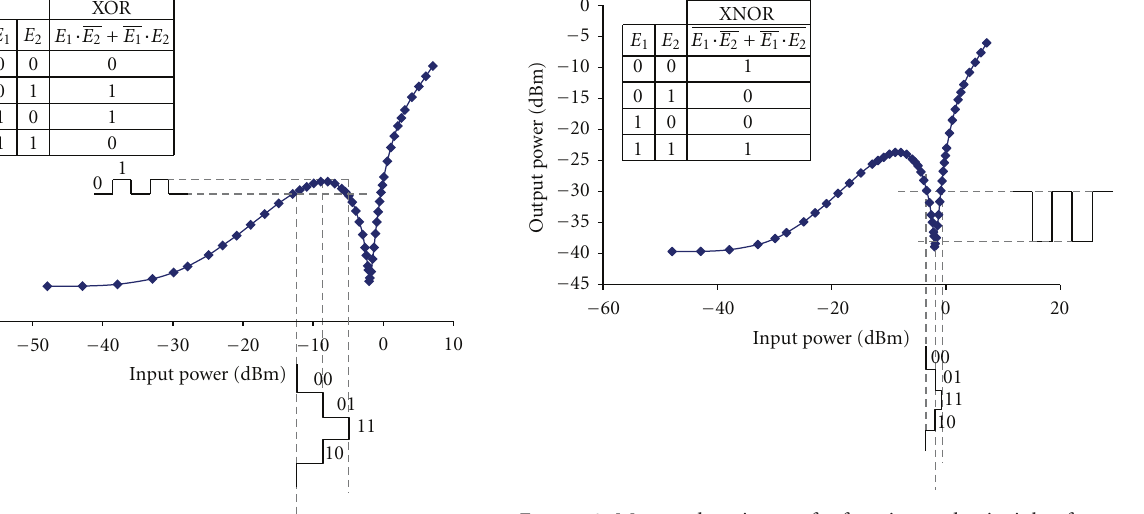
Figure 7: Measured static transfer function and principle of ope- ration for XOR function at a blocking power equal to − 2 dBm and wavelength equal to 1550 nm.